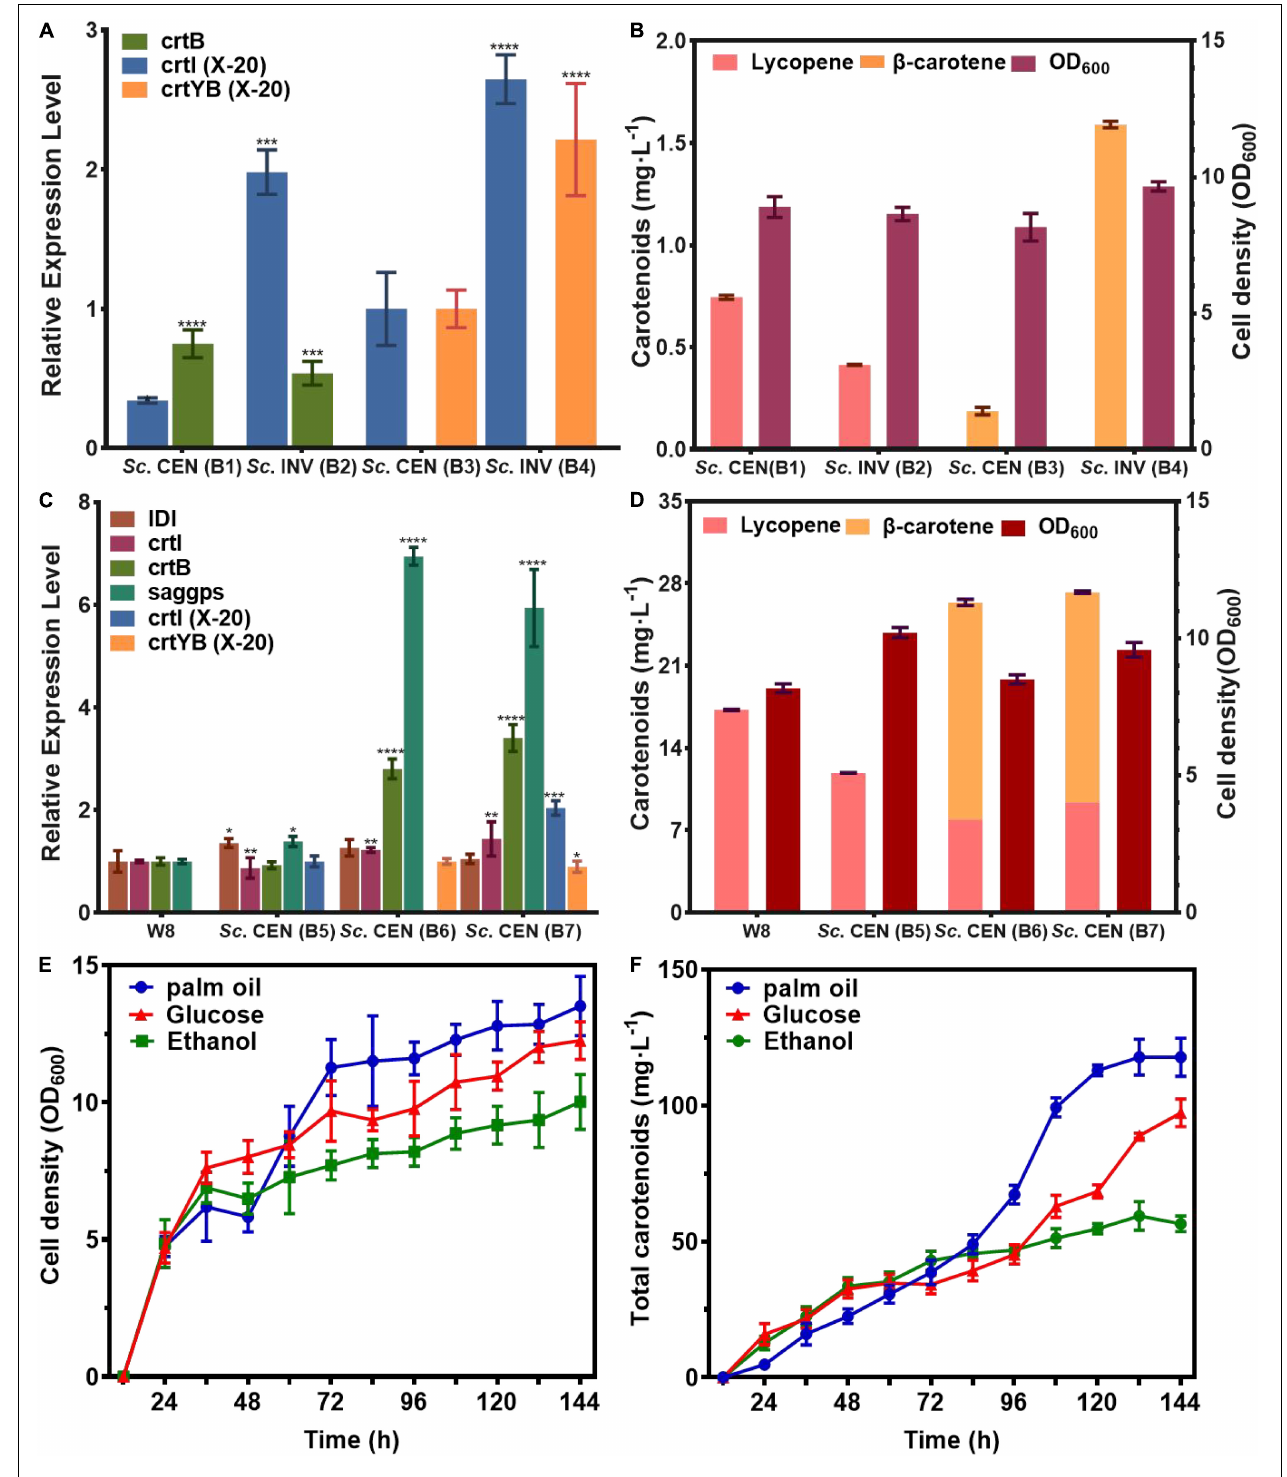
FIGURE 6 | Efficient expression and fermentation optimization of engineered strains. Validation of genetically functional engineered strains for (A) mRNA expression levels, (B) metabolite production. Optimization of (C) mRNA expression levels of genes of interest in the upstream pathway for engineered strains with (D) metabolite production. (E) Cell growth density of Sc . CEN (B7) strain, (F) total carotenoids production of Sc . CEN (B7) strain (relative mRNA levels were calculated from the mRNA of the reference gene TUB1, data shown as the mean of three independent experiments, error expressed as ± SD). Significant differences between groups were calculated by one-way ANOVA (**** p < 0.001, *** p < 0.01).